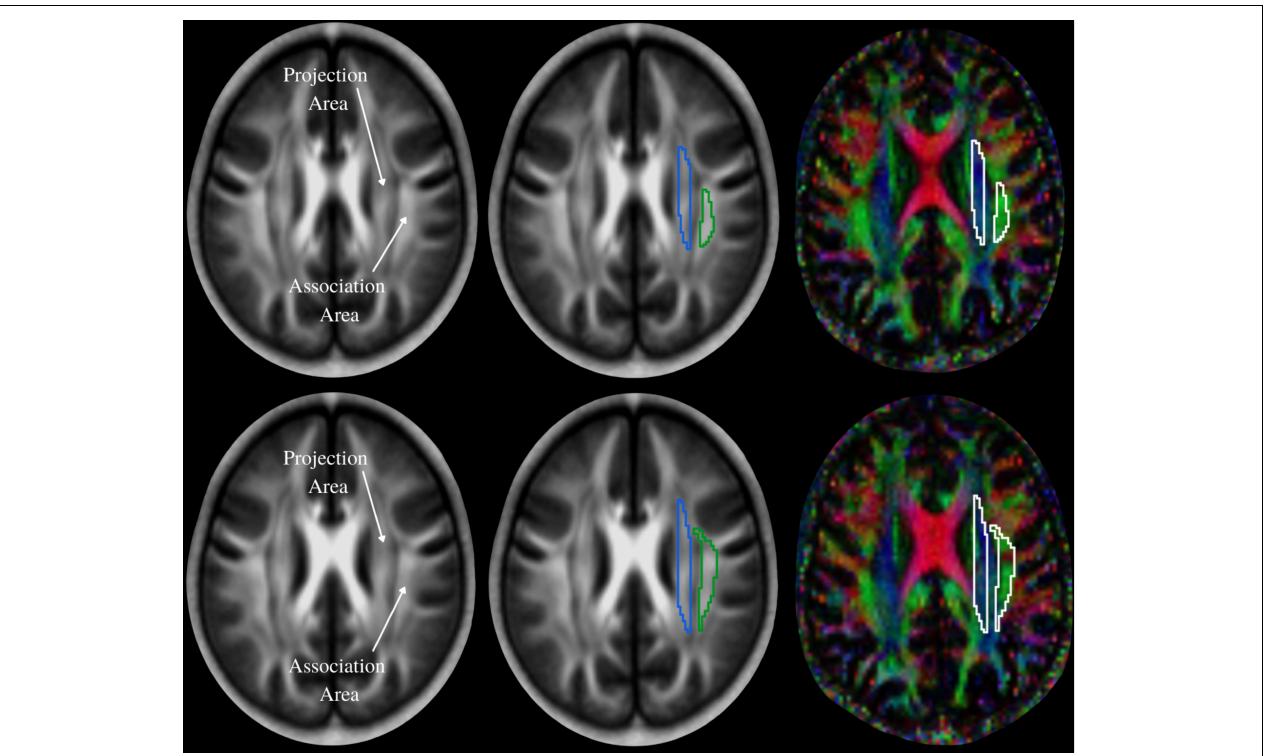
FIGURE 2 | The periventricular white matter is divided into two regions; medial blue and lateral green areas, which correspond to the projection and association fibers, respectively. Region of interest (ROI) settings are placed on the projection and association fiber areas on FA and color-coded FA maps in two different slices. Values of co-registered maps were retrieved using these